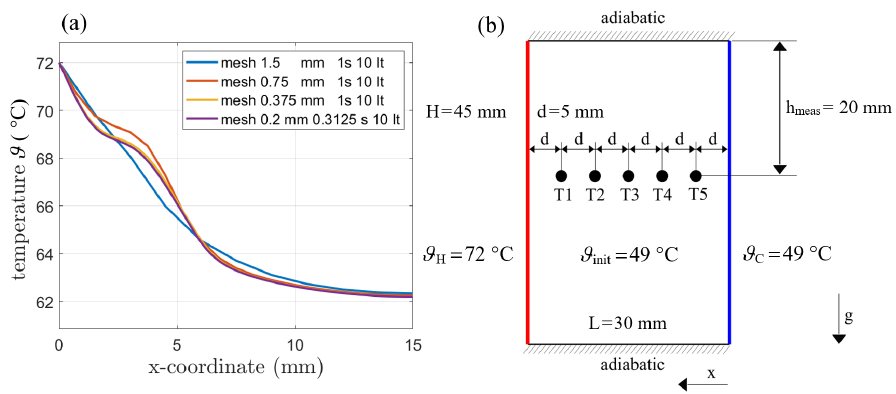
Figure 7. ( a ) Mesh refinement for AHC (var. density) for different mesh sizes. Time steps and iterations did not alter the results. ( b ) Simulation domain including the boundary conditions and positions of the temperature sensors.The phase front is tracked at the top of the